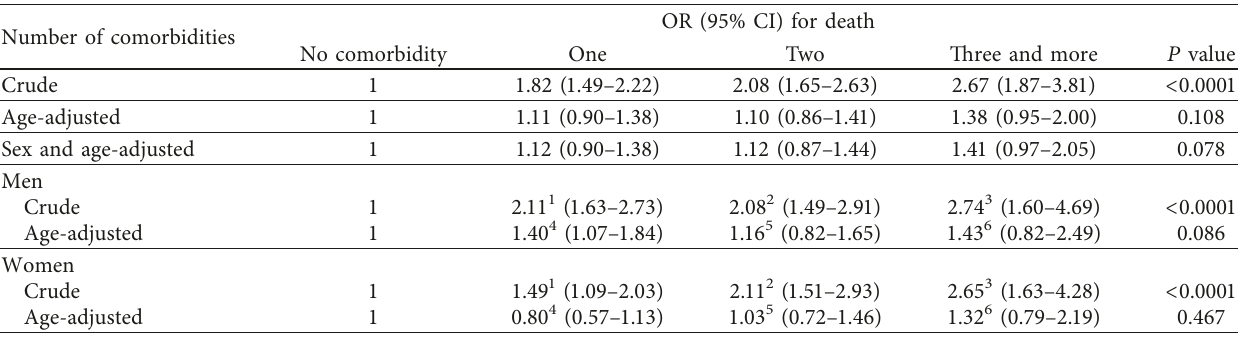
Table 5: Odds ratio and 95% confidence intervals of mortality according to the number of preexisting comorbidities in hospitalized patients with positive real-time reverse-transcription polymerase chain reaction test results for COVID-19. Number of